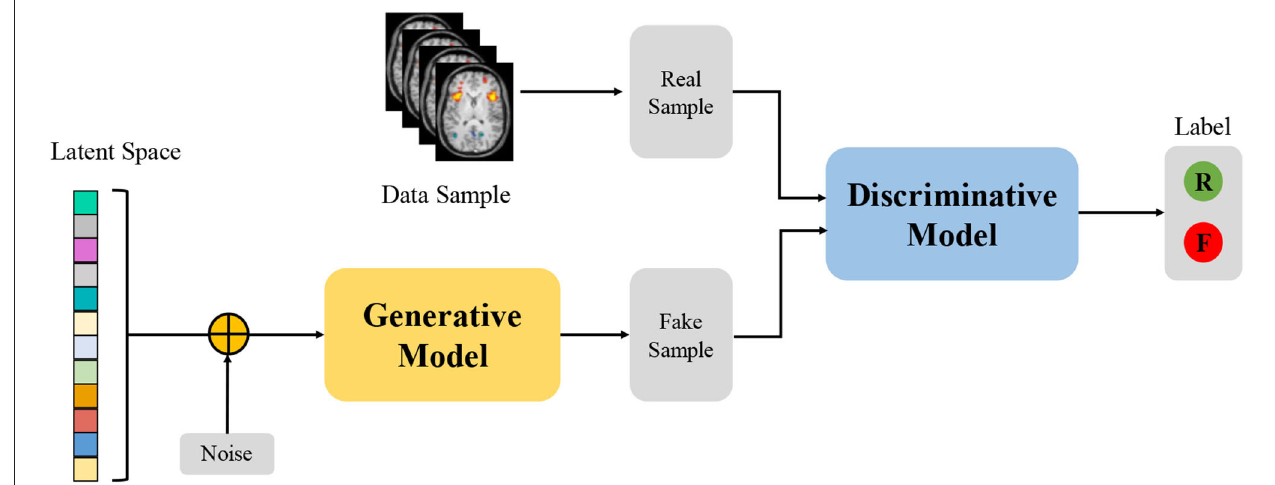
FIGURE 4 | Architecture of Generative Adversarial Networks. “R” and “F” represents the real and fake label, respectively.